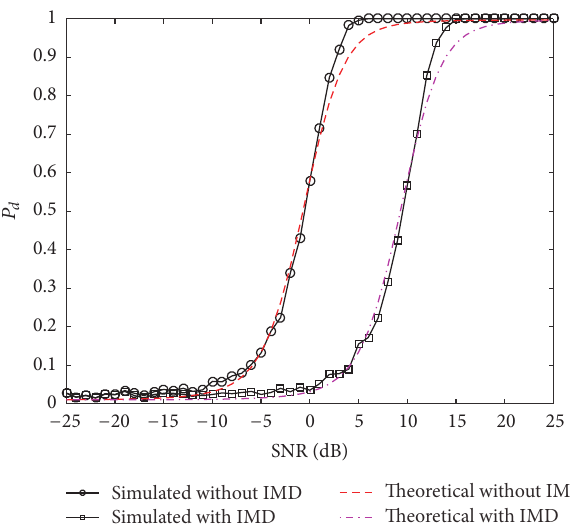
Figure 6: 𝑃 𝑑 versus SNR with IMD of 10 dB and 𝑁 = 15 .